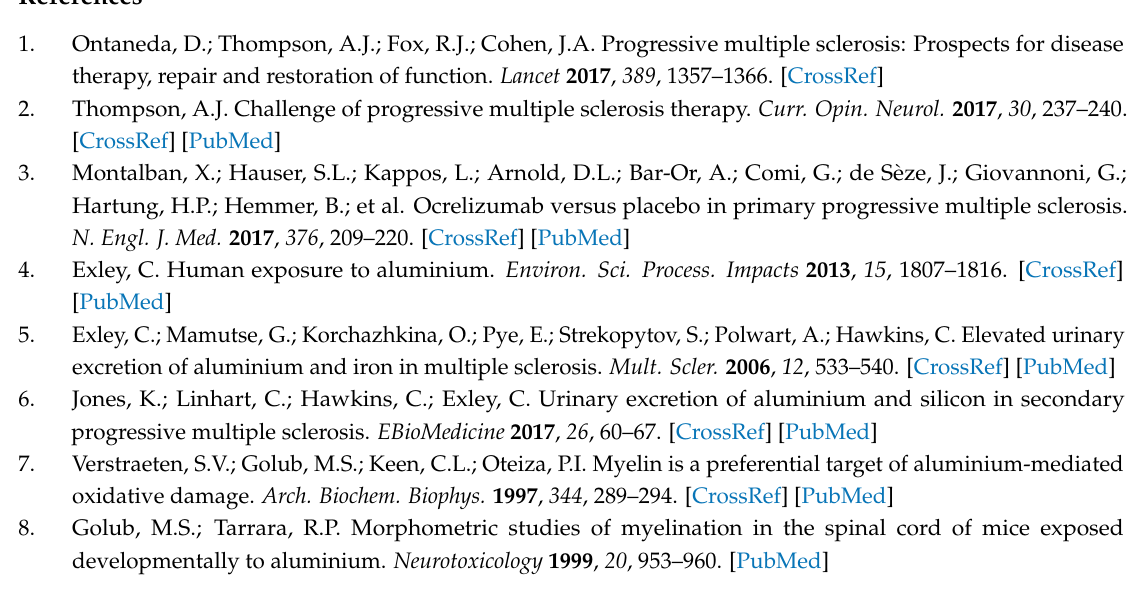
Table S9: MS401 (Female, 82 SPMS), Table S10: MS180 (Female, 44 SPMS), Table S11: MS313 (Male, 66 PPMS), Table S12: MS114 (Female, 52 SPMS), Table S13: MS203 (Female, 53 SPMS), Table S14: MS234 (Female 39,